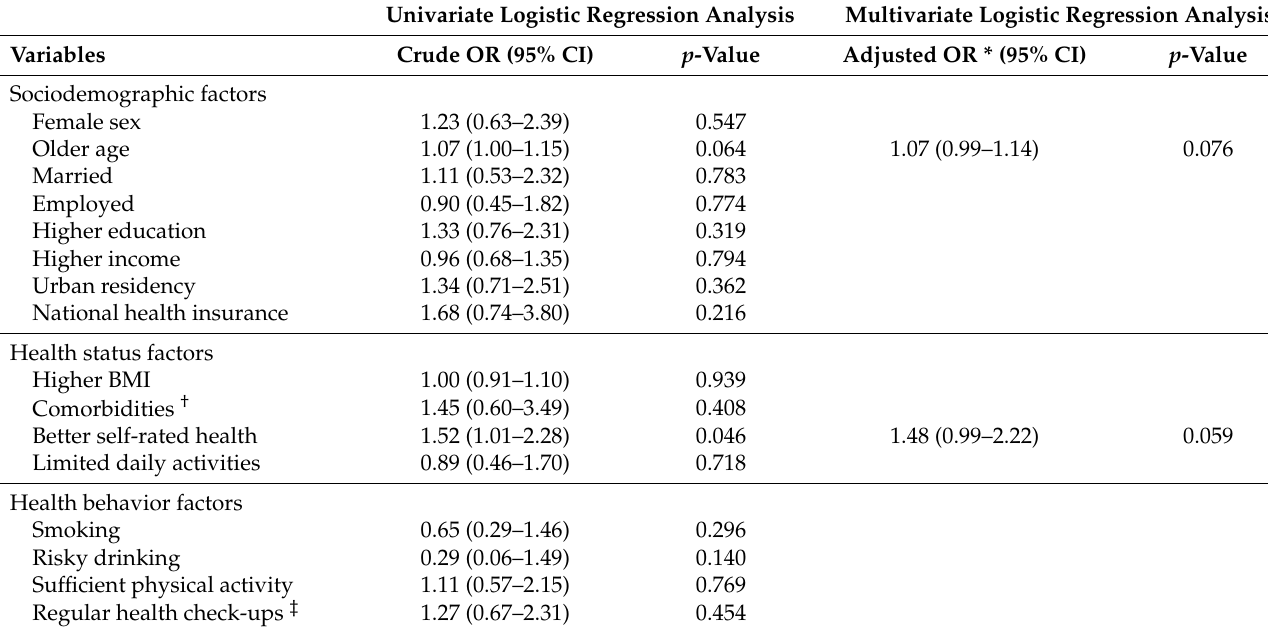
Univariate Logistic Regression Analysis Multivariate Logistic Regression